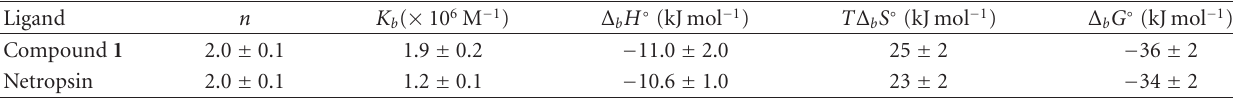
Table 1: Thermodynamic parameters for the interaction of compound 1 and netropsin with [d(TGGGGT)] 4 determined by ITC at 25 ◦ C and pH